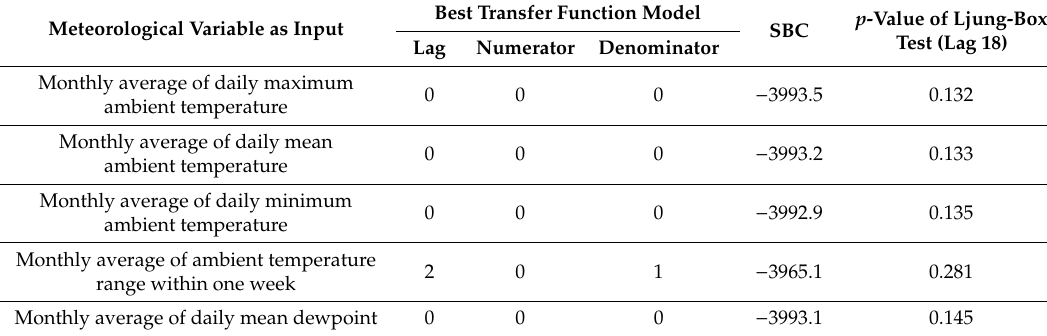
Table 4. Transfer function models for the rate of older-adult suicide deaths from nonviolent